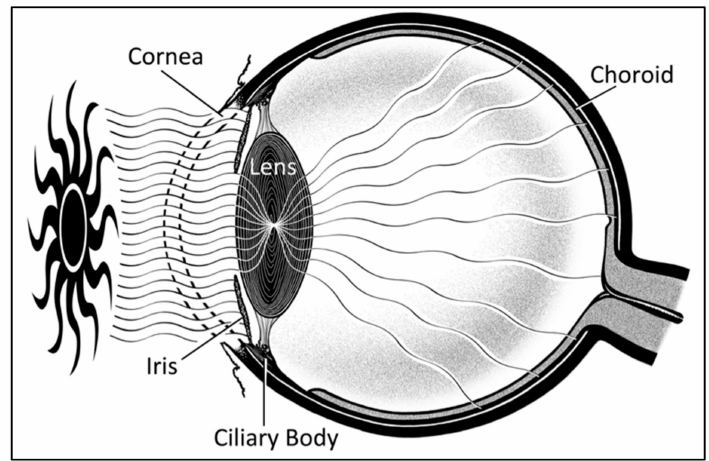
Figure 3. Sagittal schematic of the eye demonstrating ultraviolet exposure of iris and choroid, with sparing of the ciliary body due to protection by the